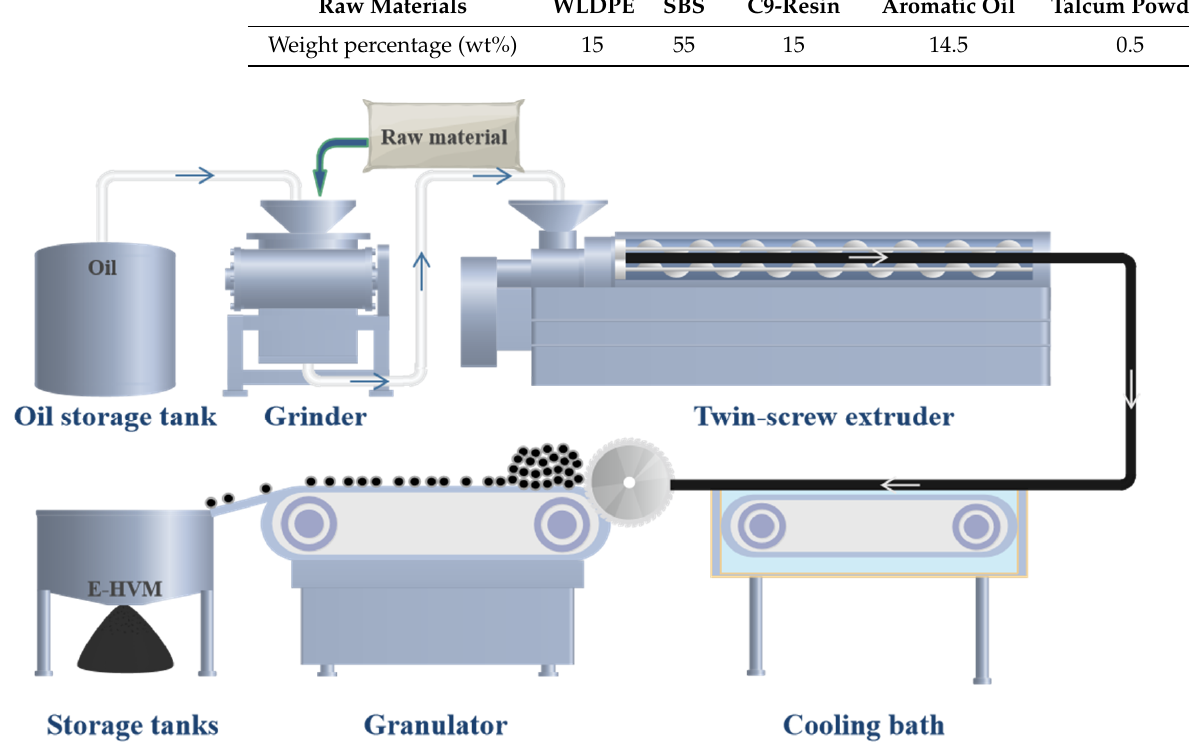
Figure 2. Flowchart of the preparation of E-HVM.